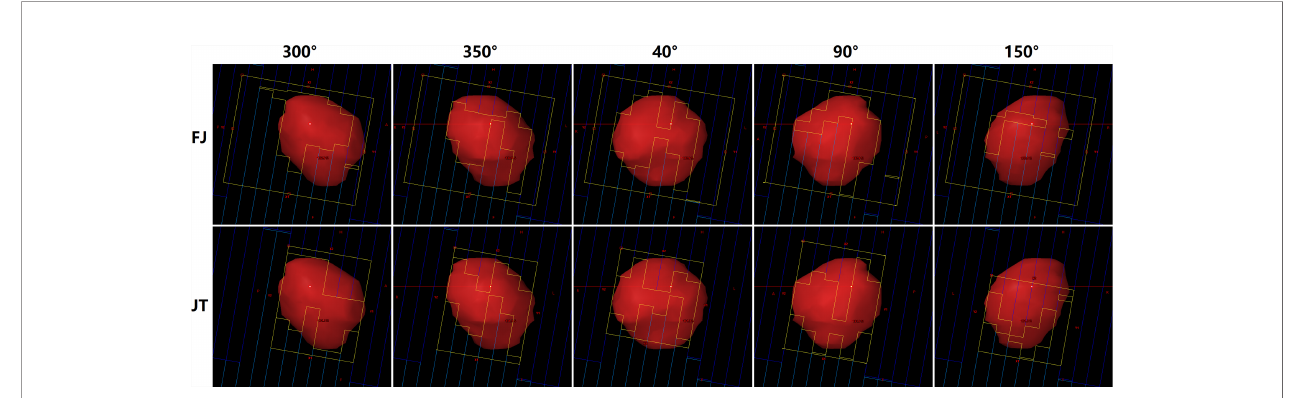
FIGURE 4 | Beam ’ s eye views at fi ve gantry angles in fi xed-jaw (FJ; upper panel) and jaw tracking (JT) plans (lower panel) of a patient.